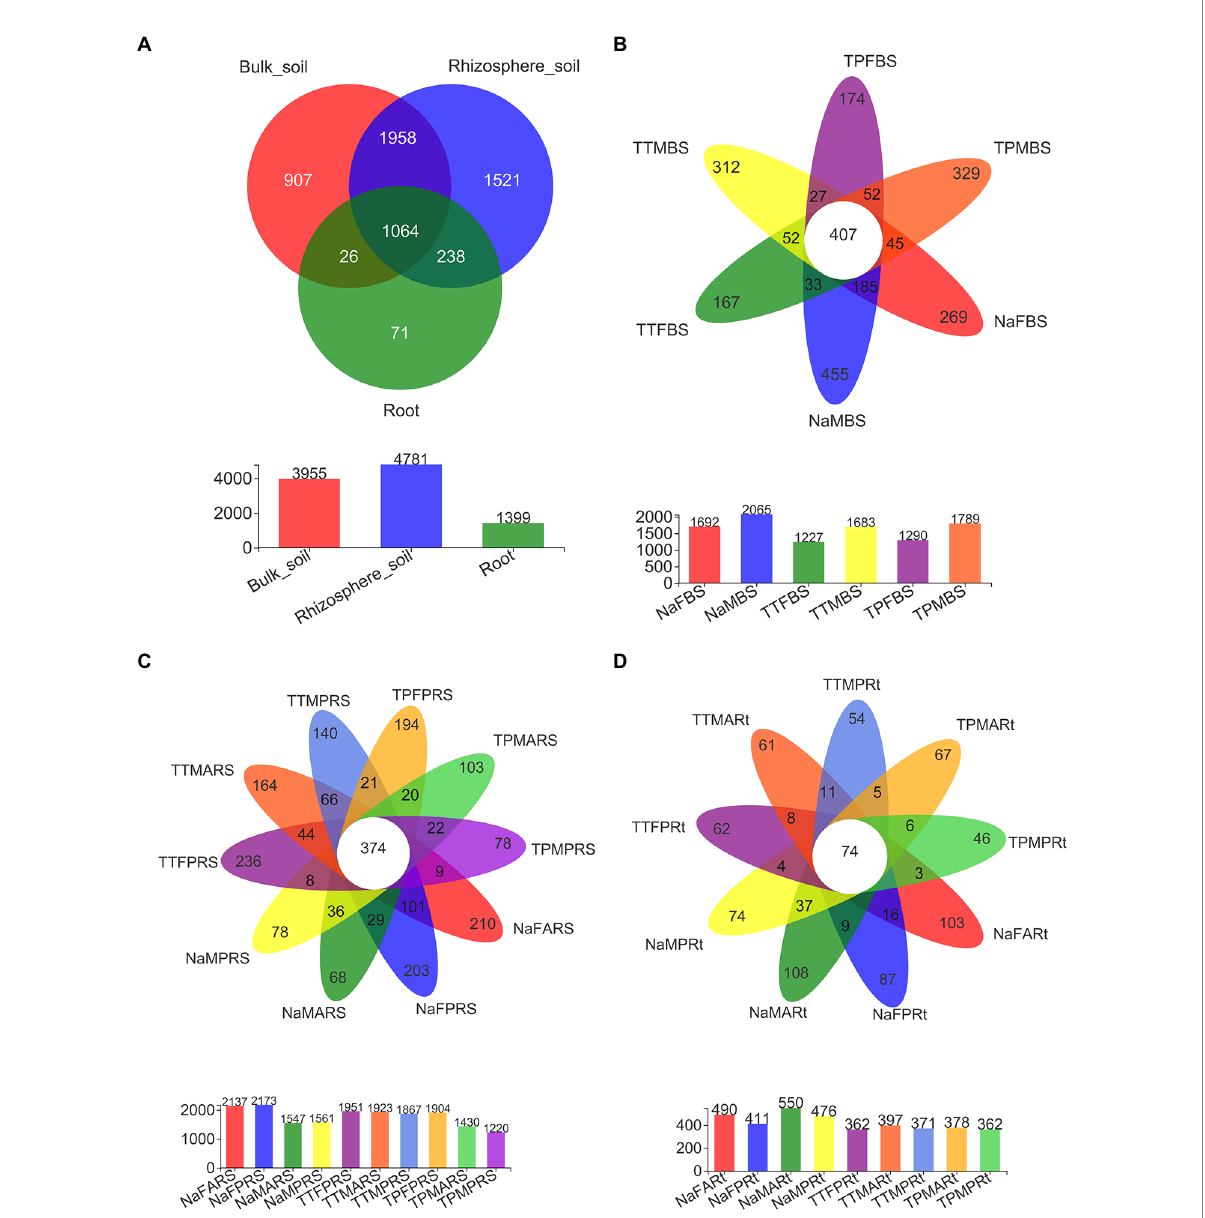
FIGURE 4 Shared and unique OTUs in different compartments and in different groups of N778 and two control sorghum lines. (A) Shared and unique OTUs in bulk soil, rhizosphere soil and root compartments. Shared and unique OTUs in different groups of bulk soil (B) , rhizosphere soil (C) and roots (D) between the 3 sorghum lines. The treatment details are shown in Figure